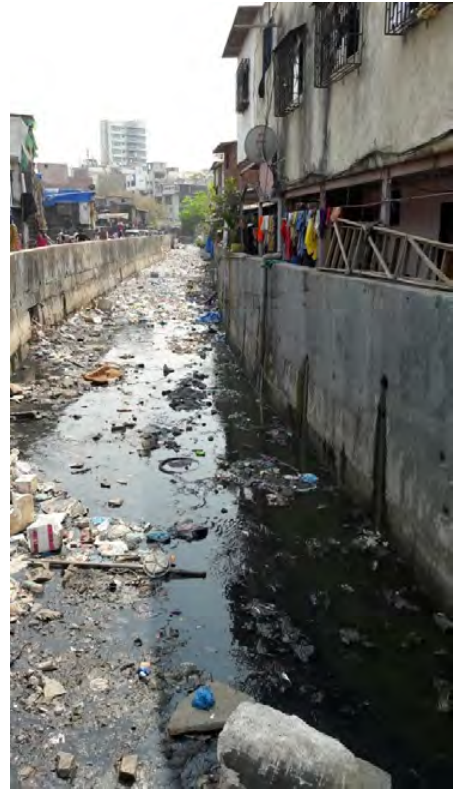
Figure 5. Gazdar Bandh slum site covered during field study